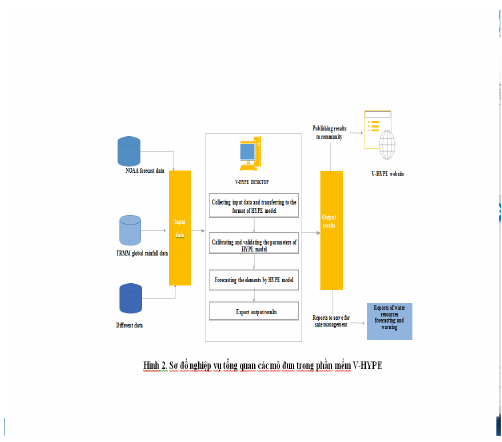
Fig. 2: Diagram of modules of V-HYPE